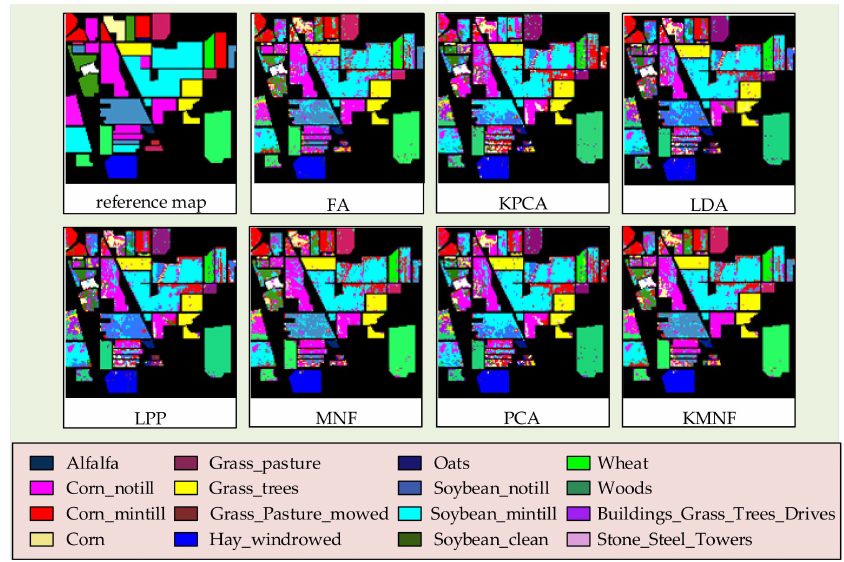
Figure 4. The results of SVM classifier for Indian Pines after each feature extraction method (number of features =